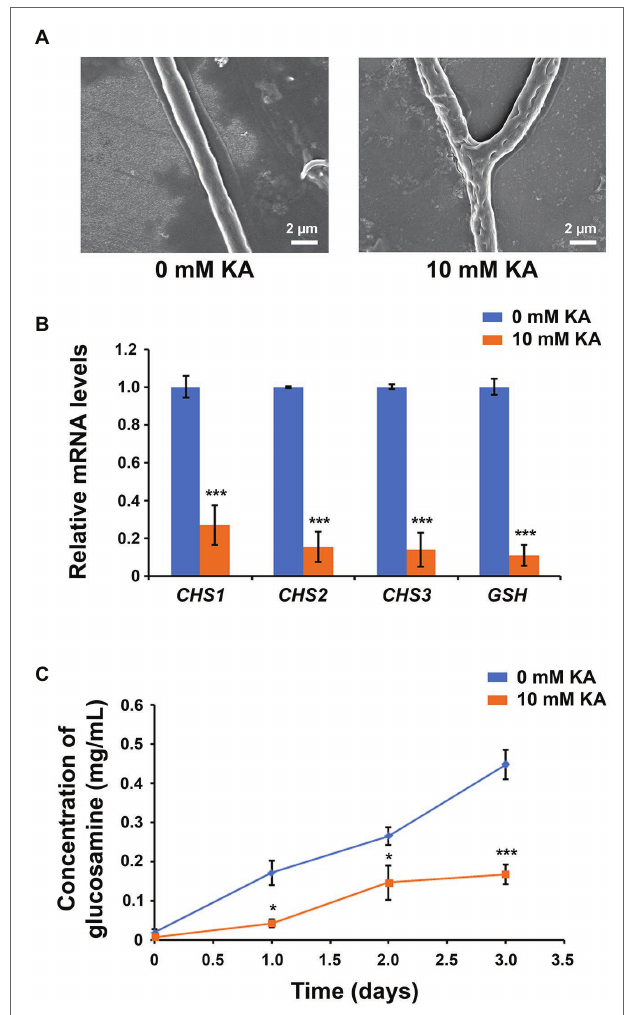
FIGURE 3 | Kojic acid inhibits chitin synthesis and alters cell wall integrity in Sclerotinia sclerotiorum . (A) Scanning electron microscope (SEM) observations of S. sclerotiorum cell wall after treatment with 10 mM KA (1.42 mg/ml KA). (B) Relative mRNA levels of chitin synthase genes CHS1 , CHS2 , and CHS3 , and β -1,3-glucan synthase gene GSH , in S. sclerotiorum after treatment with 10 mM KA (each treatment mean represents the average of five repetitions). (C) Concentration of chitin, measured by the concentration of glucosamine after hydrolysis, in S. sclerotiorum cells after treatment with 10 mM KA (each treatment mean represents the average of three repetitions). Significance levels at * p < 0.05 and *** p < 0.001. Bars represent the